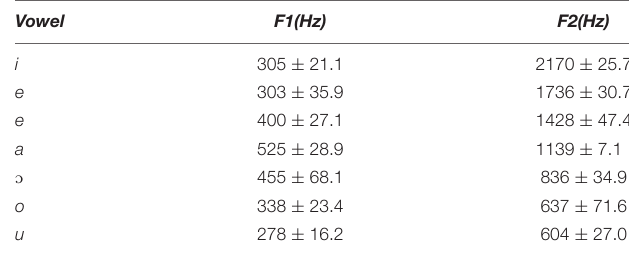
TABLE 1 | Average F1 and F2 values and standard deviations for each